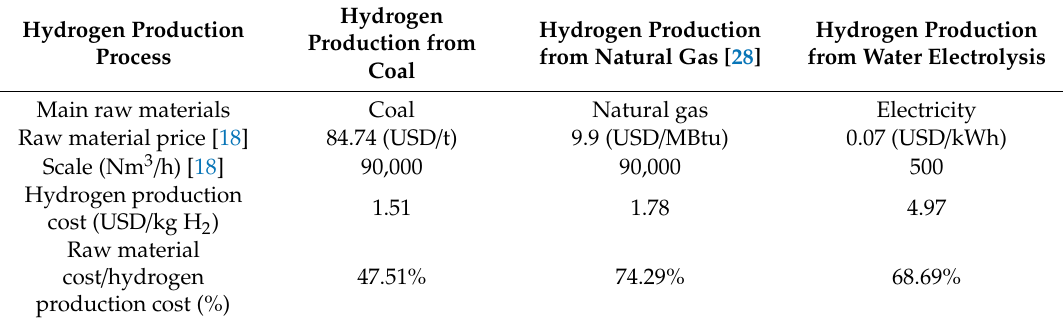
Table 4. Raw materials for di ff erent hydrogen production